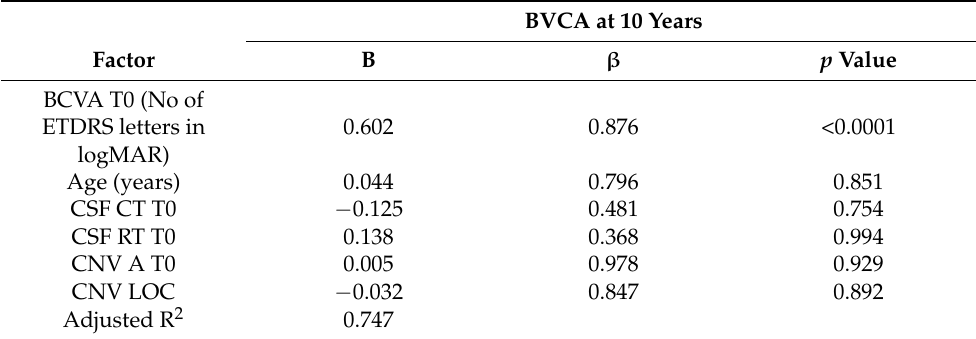
Table 4. Multivariate regression analysis to evaluate the contribution of each pretreatment factor on final BCVA at 10